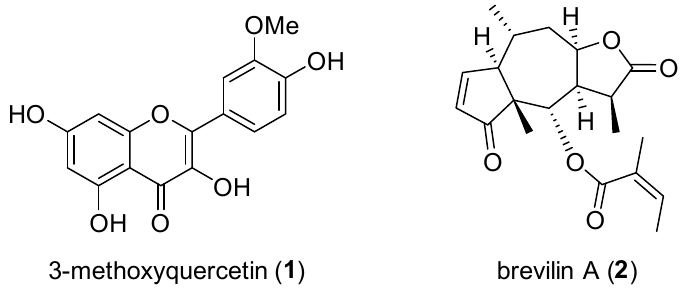
Figure 3. Purified compound identification. The chemical structures of compounds 1 and 2 .